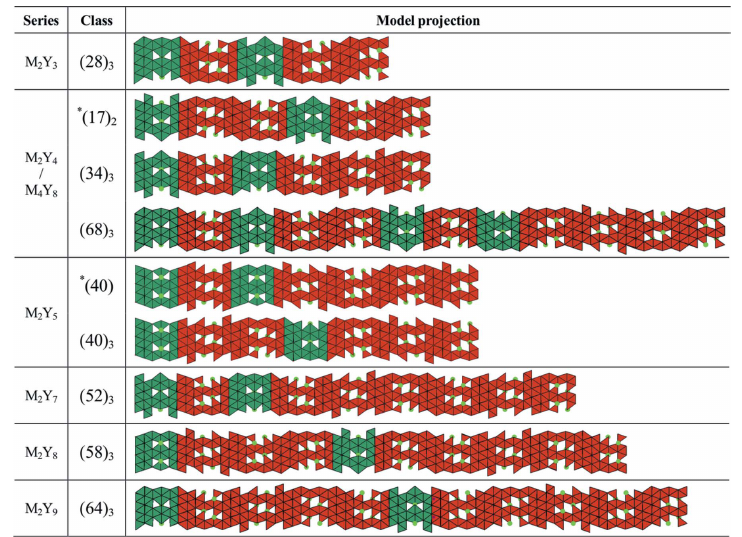
Figure 9 Projections of the mixed-layer hexaferrites along the [100] direction highlighting the different stacking sequences. Green and red blocks correspond to M and Y blocks, respectively. The asterisk indicates a class with hexagonal or trigonal symmetry, all others are rhombohedral. For the latter, unit cells contain a threefold repeat of the represented sequences, with subsequent repeats translated in-plane by (2/3, 1/3).